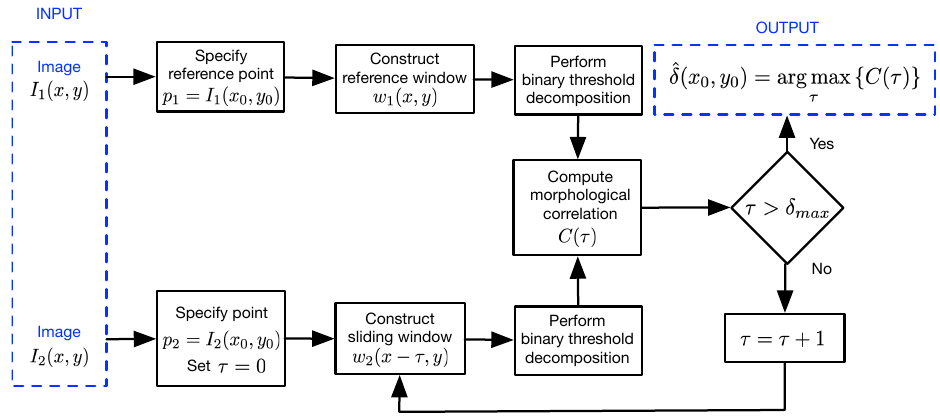
Figure 3. Block diagram of the proposed method for stereo matching based on adaptive morphologi- cal